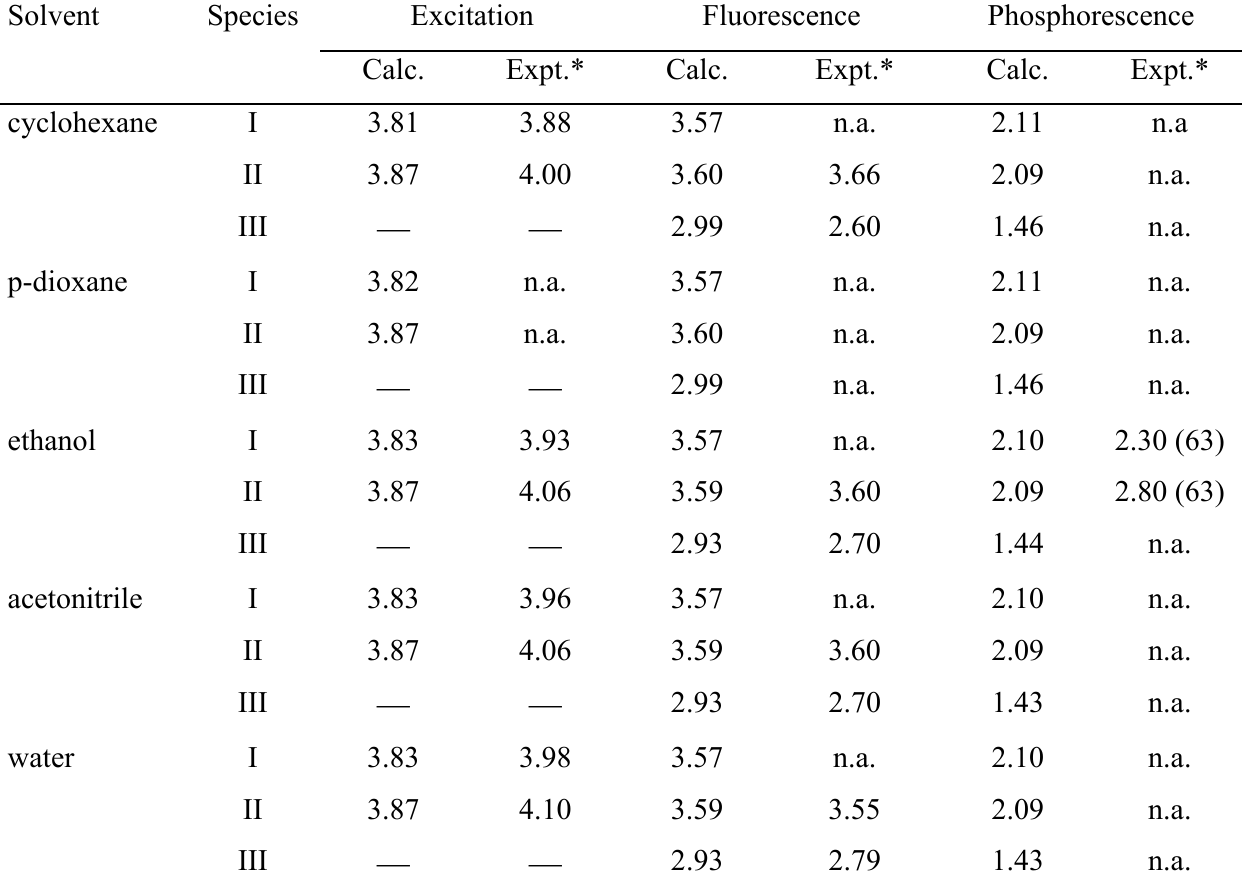
Table 12. Assignment of excitation, fluorescence and phosphorescence spectra of HPO in different solvents in terms of calculated energies (eV). Numbers within parentheses refer to the references corresponding to the experimental data. (n.a. indicates non-availability of